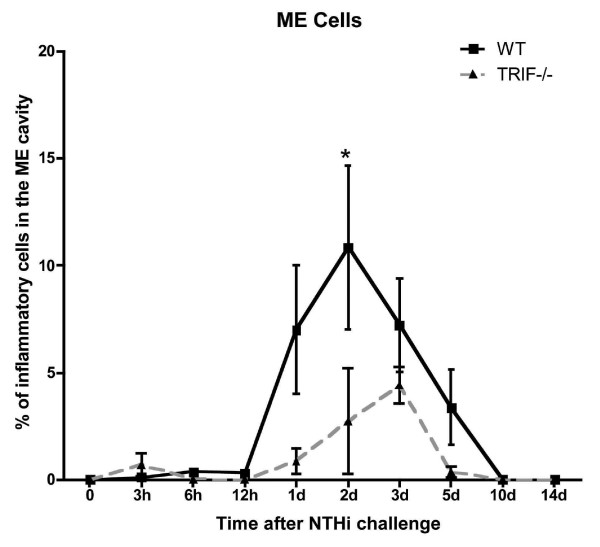
Inflammatory cells in the ME of WT versus TRIF-/- mice during OM. Area of the ME cavity covered by infiltrating cells, measured at standardized locations in the ME of WT and TRIF-/- mice before (0 hr) and after ME inoculation with NTHi. Each data point represents the mean of 6 MEs. Bars represent one standard deviation. Significant difference between WT and TRIF-/- mice: *P < .05.